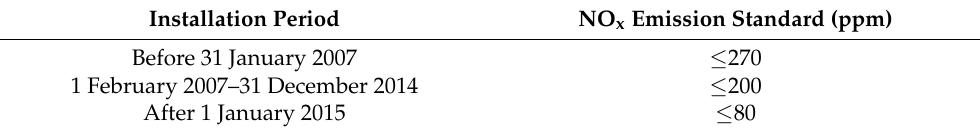
Table 2. NO x emission standards for cement industry kilns in South Korea (data taken from [17]).